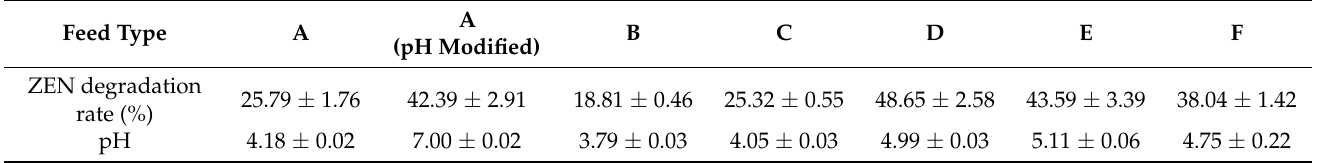
Table 2. Degradation of ZEN in different feedstuffs by F39 and the pH values of each